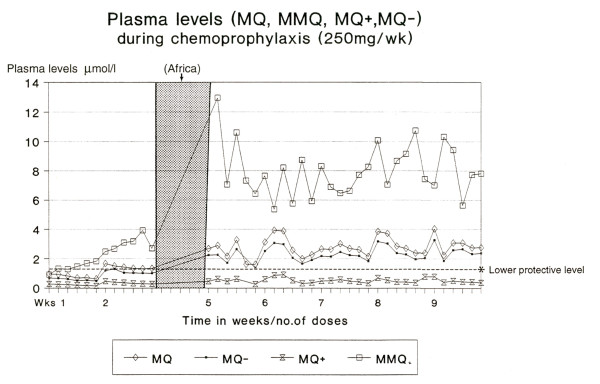
Plasma levels achieved during chemoprophylaxis in adult travellers. Data [52] showing plasma levels achieved during weekly prophylaxis in adult travellers, prior to travel in Africa and post travel. *Protective levels of mefloquine (620 ng/mL or 1.67 μmol/L) are achieved after two weeks of chemoprophylaxis dosing. The plasma profile in adults is similar to that in the simulated profile in children (Figure 1). MQ: mefloquine, MQ+, MQ-: mefloquine enantiomers, MMQ: carboxylic acid metabolite of mefloquine